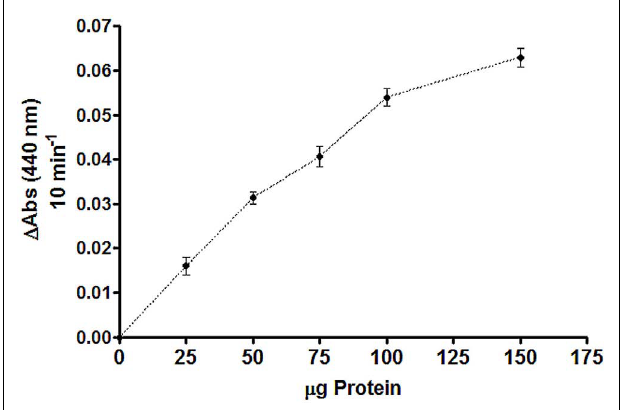
FIGURE 3 | Recombinant expression and purification of Vs DapL using affinity chromatography. Lane (1) Protein Marker (kDa), Lane (2) 10 μ g of soluble protein from uninduced cells, Lane (3) 10 μ g of soluble proteins from induced cells, Lane (4) 1 μ g of purified Vs DapL.The proteins were resolved on a 10% (w/v) acrylamide gel and were stained with Coomassie blue for